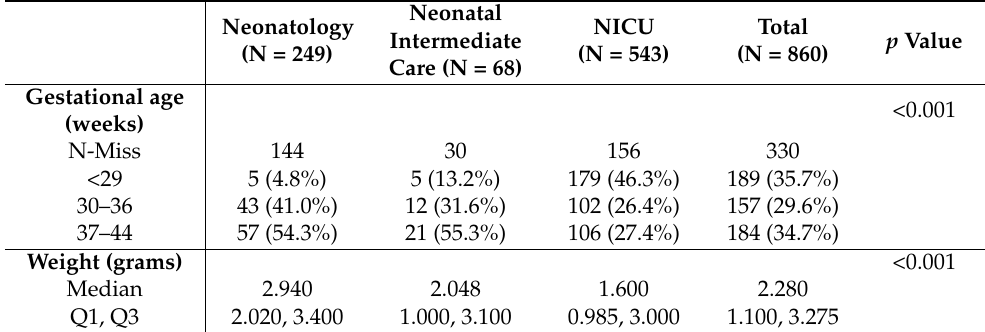
Table 3. Distribution of neonates in hospital units according to gestational age and